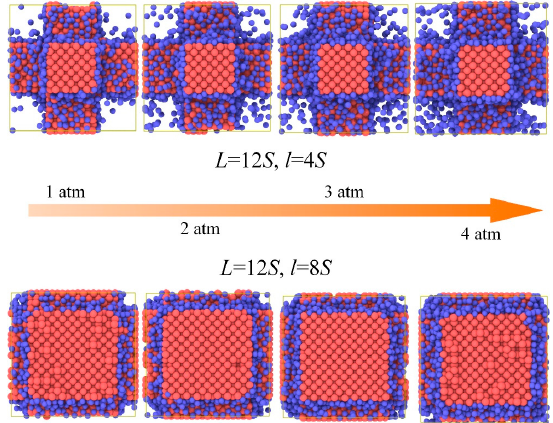
Figure 3. Gas atoms distribution in the nanoporous systems.